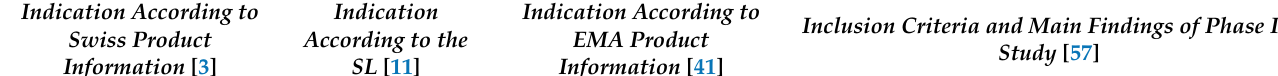
Table 5. Ponesimod (Ponvory ® ), approval CH